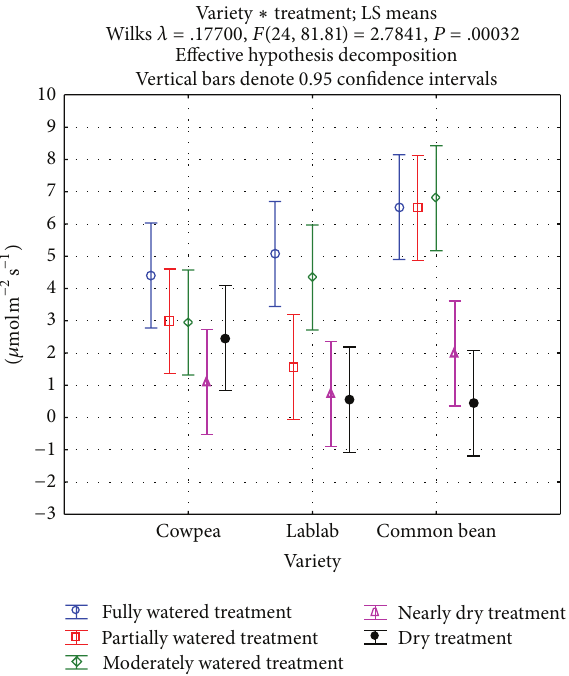
Figure 15: Photosynthesis rate on 58 DAP.